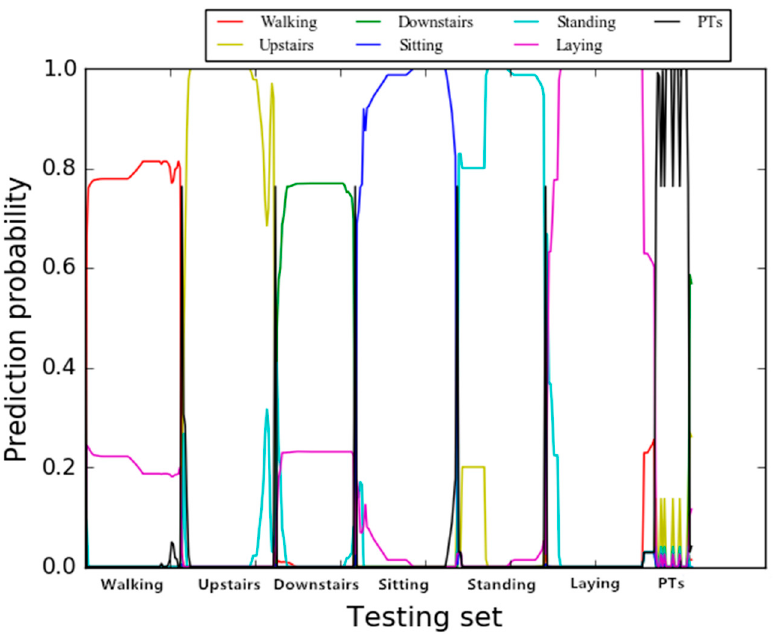
Figure 13. Seven classification probability estimation result.